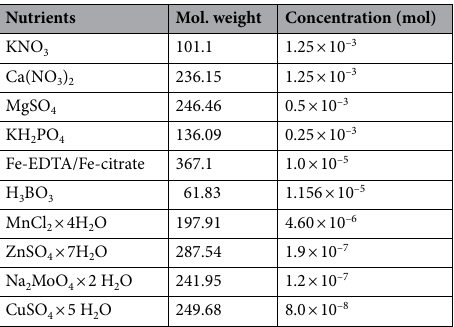
Table 6. The composition of the solution used for watering the plants.